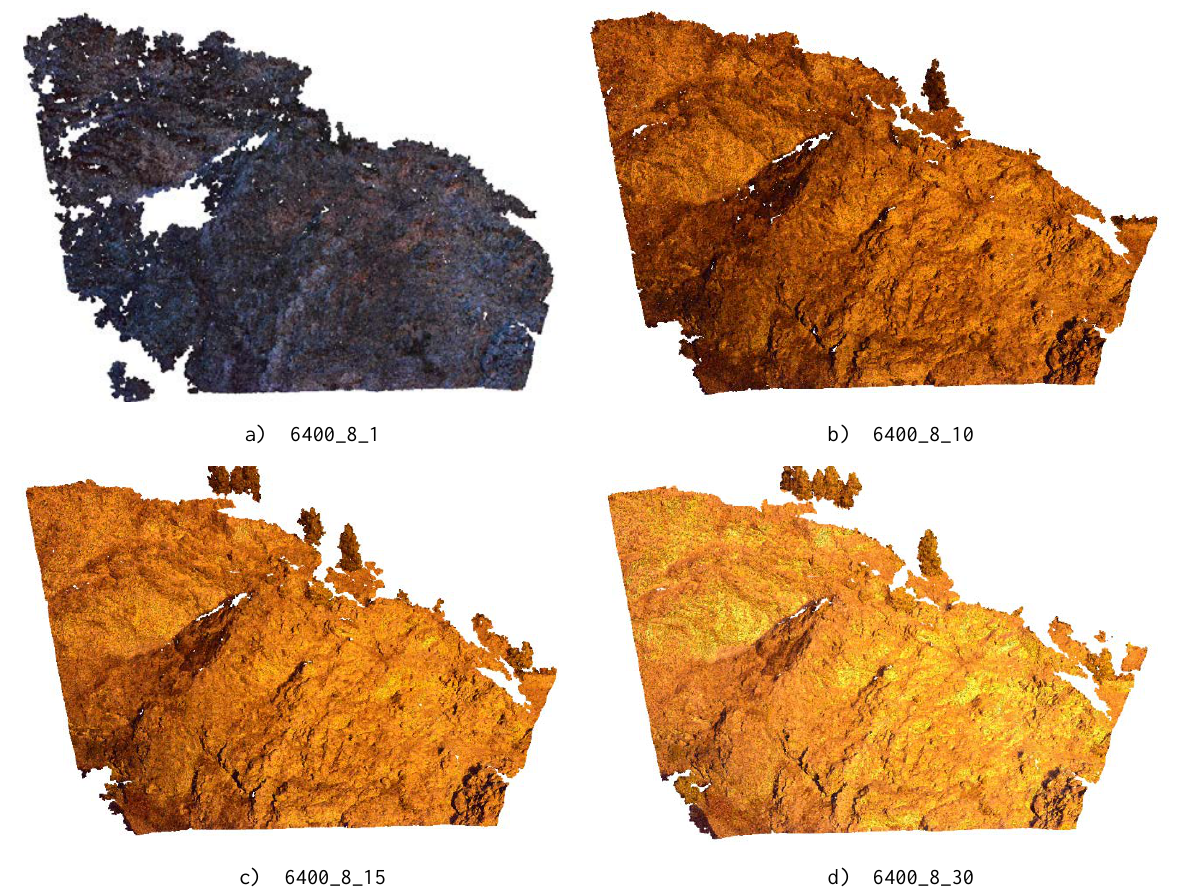
Figure 7 – RGB point clouds from the night session generated with ISO 6400, aperture 8 and different time of exposure: